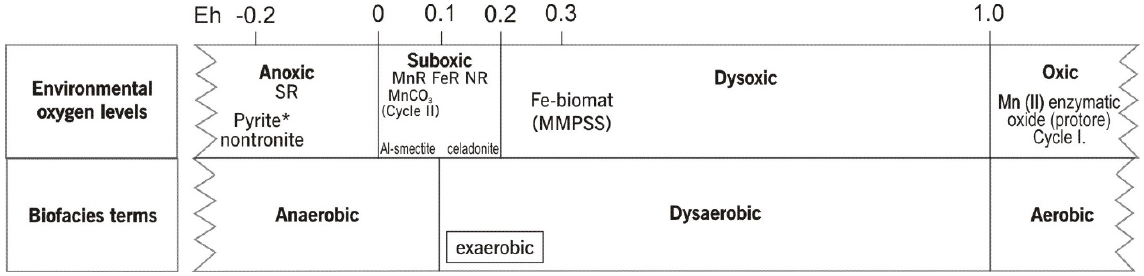
Figure 1. Terminology of oxygen-restricted environments and facies, mineralogy, and Fe-rich biomat formation conditions [1,33]. * Mat pyritization is seen in thin sections of the Úrkút Mn deposit; Eh values are in volts. MMPSS—mineralized microbially produced sedimentary structures; NR—nitrate reduction zone; FeR—Fe 3+ reduction zone; MnR—Mn 4+ reduction zone; SR—sulfate reduction zone. Cycles I and II are the two-step microbially mediated Mn-carbonate formation model. Cited from [2], with permission of GSA Publishing House.